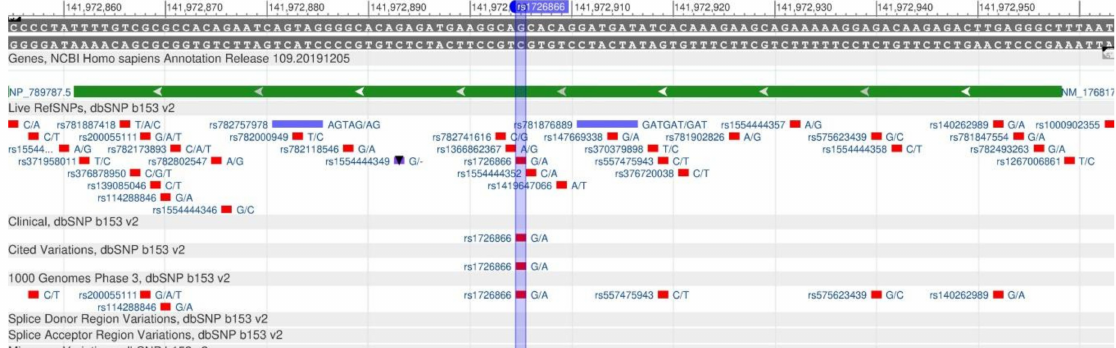
Figure 26. The TAS2R38 gene region (located on the long (q) arm of chromosome 7) containing the oligonucleotide polymorphism